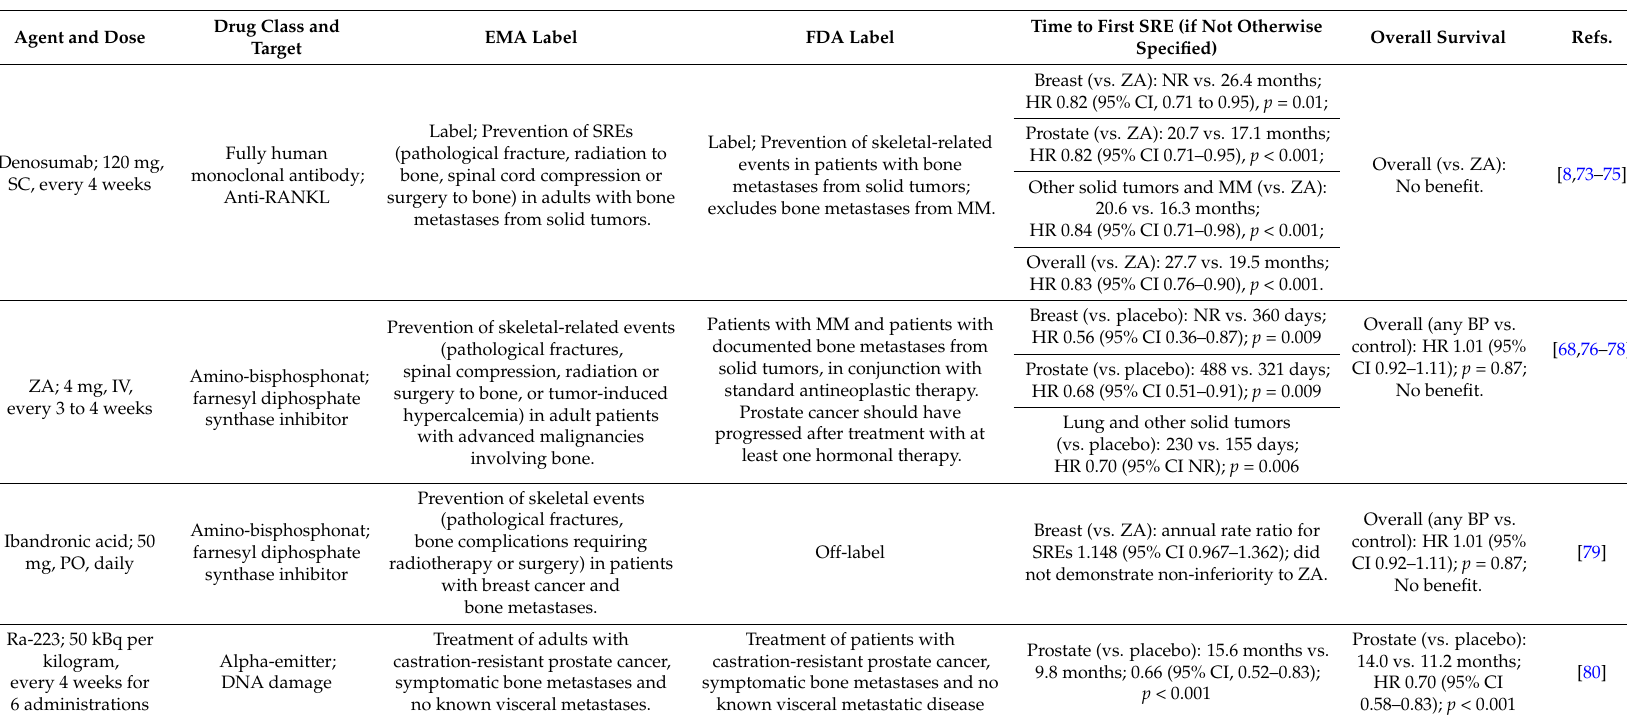
Table 1. Current data on the use of bone-targeted agents in patients with bone metastasis. Abbreviations: CI, confidence interval; HR, hazard ratio; NR, not reached; SC, subcutaneous; ZA, zoledronic acid; MM, multiple myeloma; EMA, European Medical Agency; FDA, Food and Drug Administration; SRE, skeletal related events; RANKL, receptor activator of NF κ B ligand; BP, bisphosphonates; IV, intravenous; PO, per os